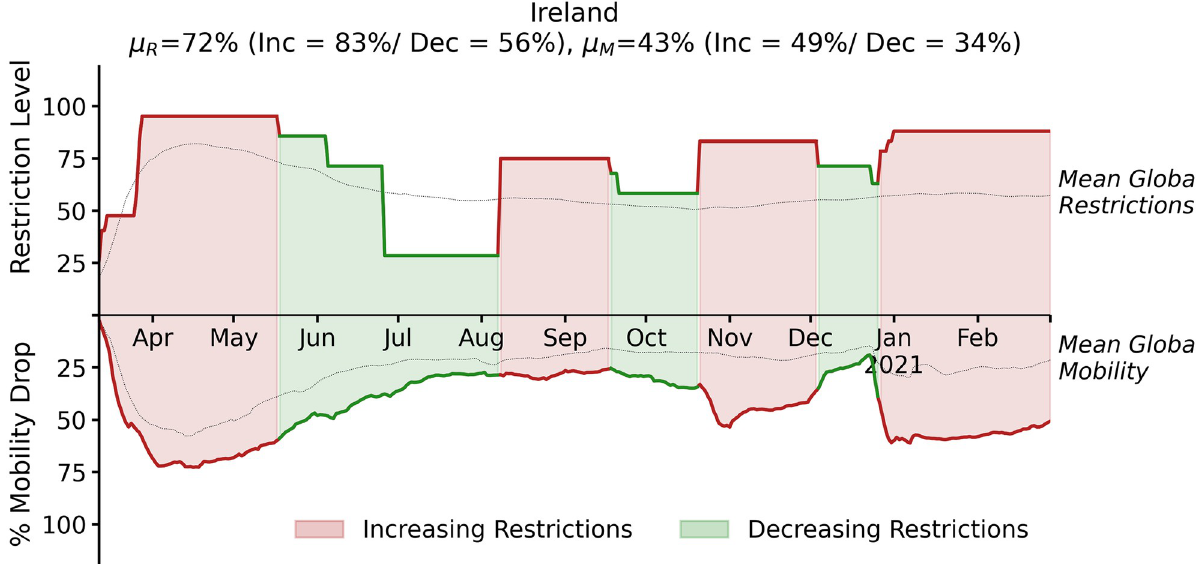
Fig 1. The travel-related restriction (upper graph) and mobility data (lower graph) for Ireland (7d rolling averages), from March 2020 to February 2021, inclusive. The mean global restrictions and mobility drops are also indicated as separate line graphs. The title of the graph shows the overall mean level of restrictions for Ireland ( μ ) with the means for increasing ( Inc ) and decreasing ( Dec ) periods indicated in brackets. Similarly, the R mean mobility drop for Ireland ( μ M ) and the corresponding means for the increasing and decreasing periods are also shown in